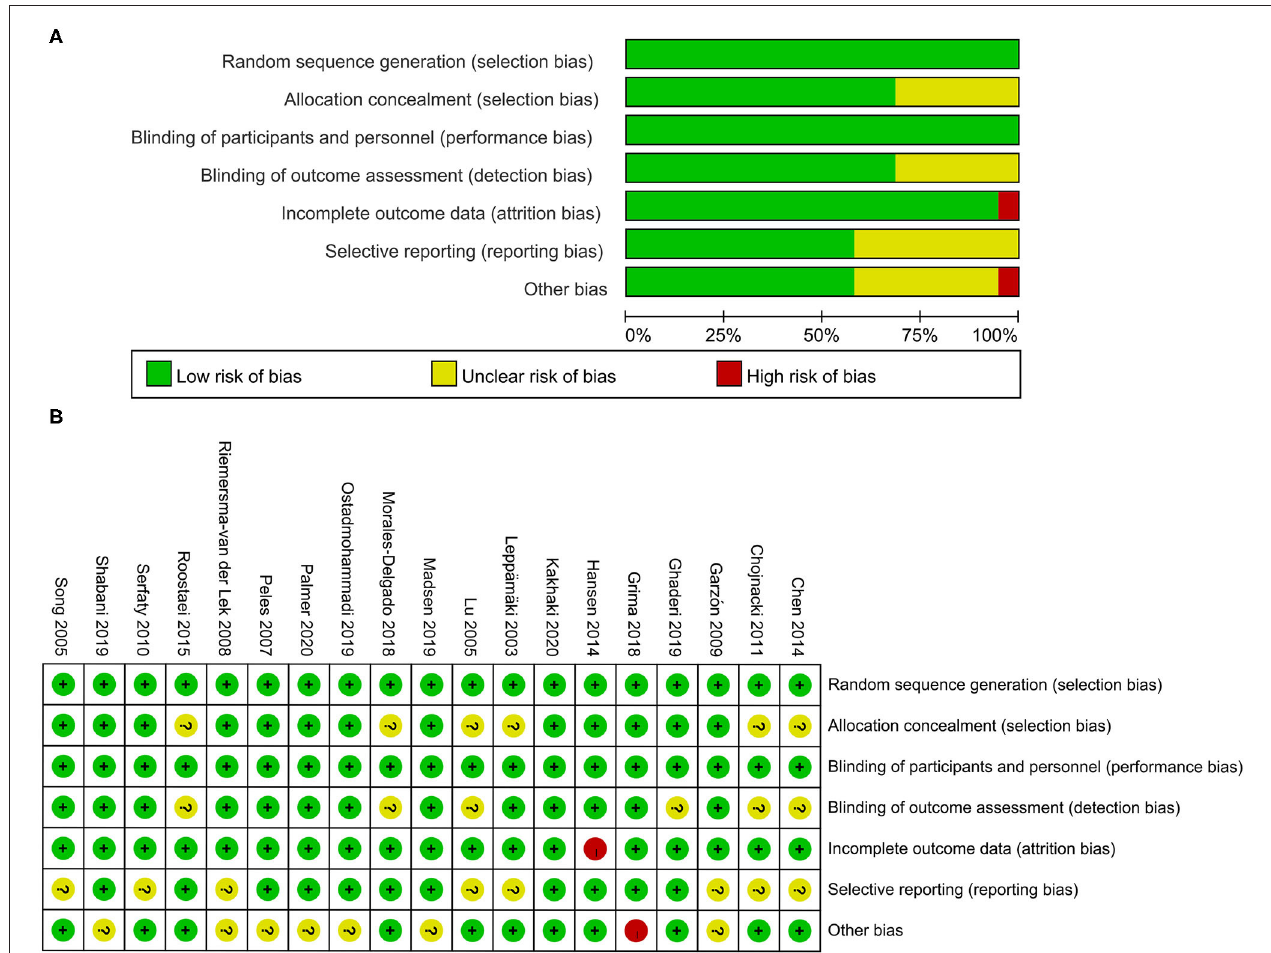
FIGURE 3 | (A,B) Risk of bias graph and summary. Green means low risk of bias; yellow means unclear risk of bias; red means high risk of